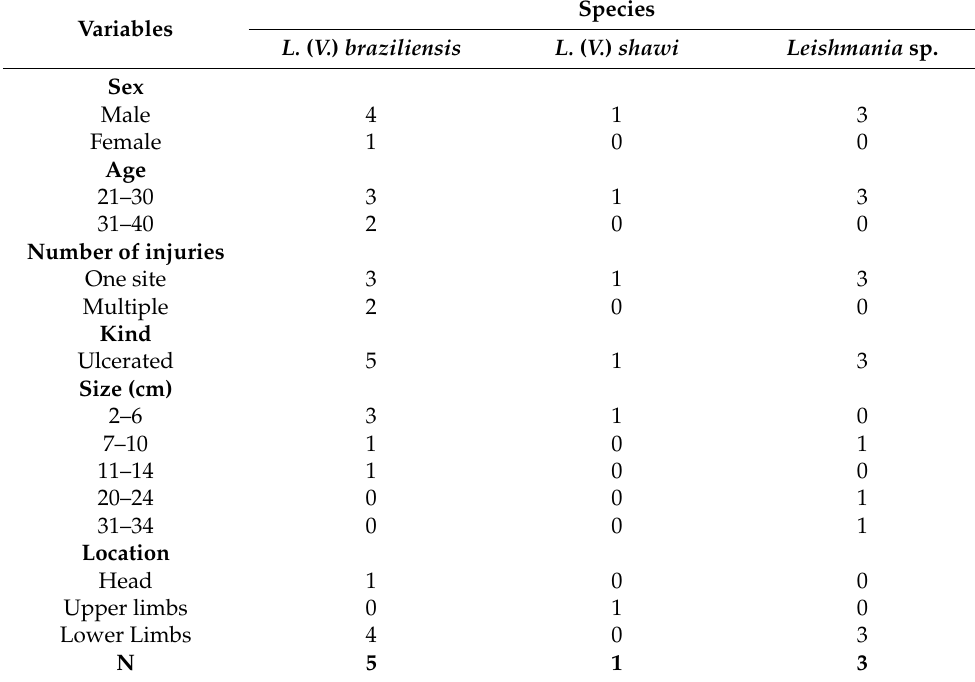
Table 2. Sociodemographic information of patients with TL (n = 9) and characteristics of lesions in the localized cutaneous form and their etiological